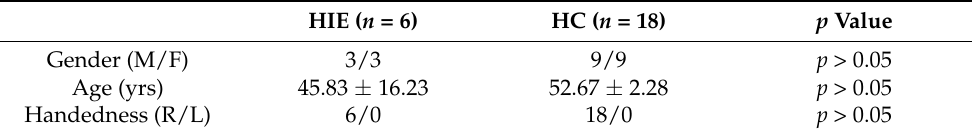
Table 2. Demographic